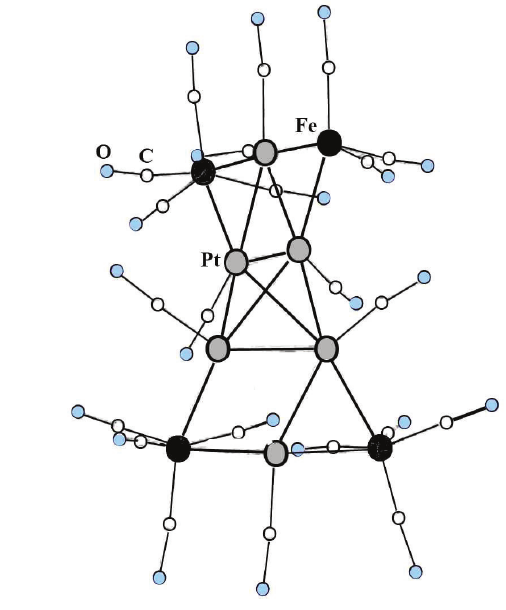
Fe (CO) ] 2- [23]. 6 4 22